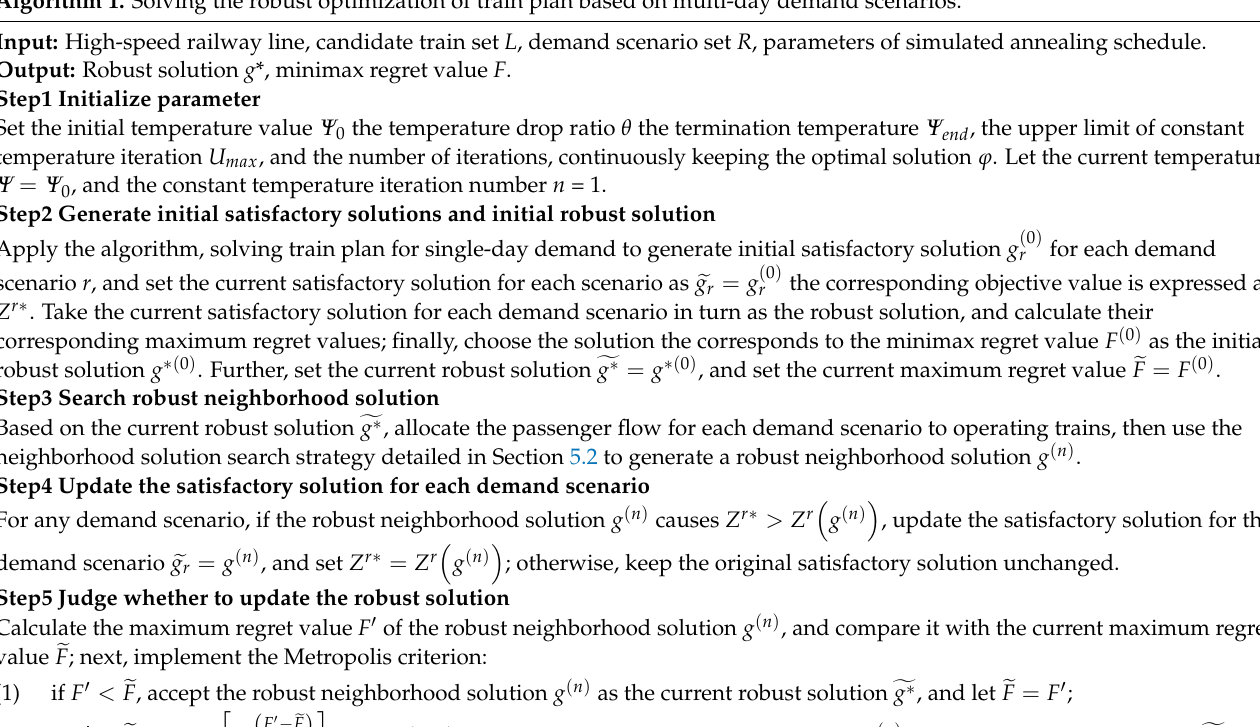
Algorithm 1. Solving the robust optimization of train plan based on multi-day demand